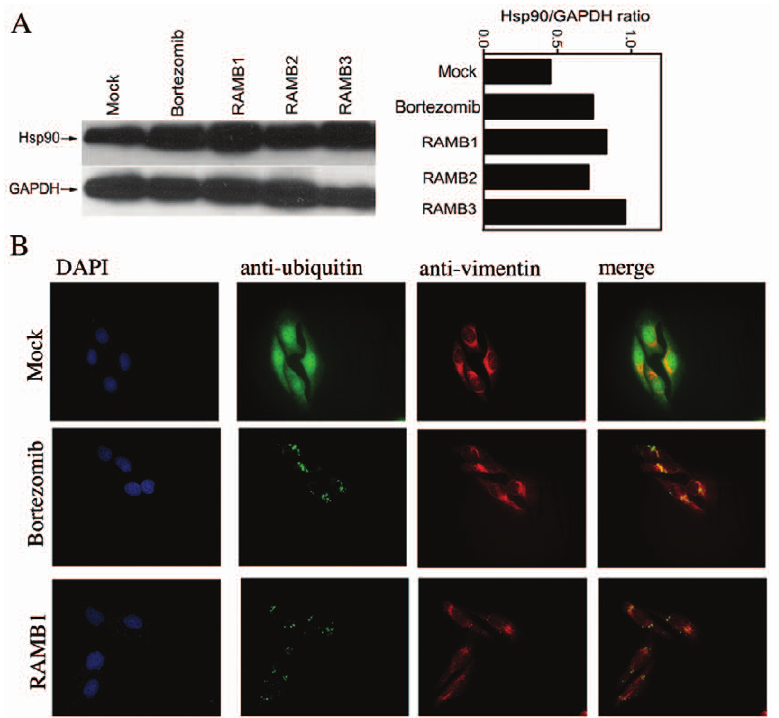
Figure 6. RAMB treatment induces accumulation of Hsp90 and aggresomes. A. Left panel: immunoblot analysis of Hsp90 expression levels in HeLa cervical cancer cells after 8 hours exposure with or without 10 m M RAMBs treatment. Bortezomib was used as positive control. Equal protein loading in each lane was verified by using an antibody against GAPDH. Right panel: Quantification of the Hsp90/GAPDH ratio. B. HeLa cells were incubated with or without 5 m M RAMB1 or 10 nM Bortezomib for 18 hours before fixation and immuno-fluorescent staining of DNA (blue), ubiquitin (green) and vimentin (red) before imaging (60 6 ).